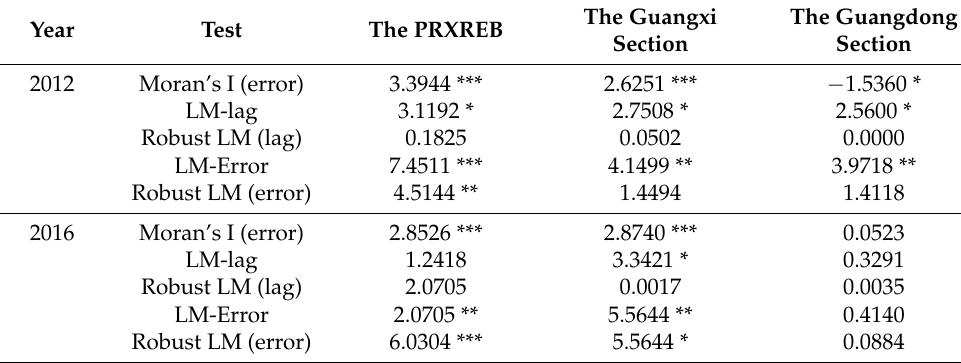
Table 1. Parameter estimation results of spatial effects in 2012, 2016.